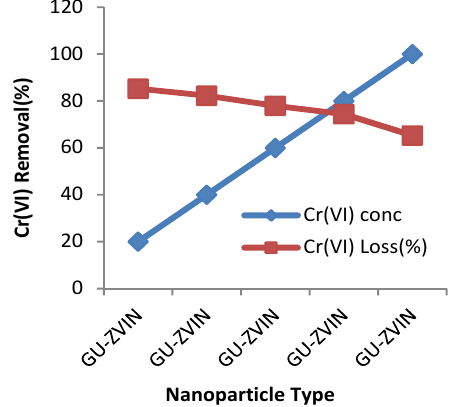
Fig.12.The removal efficiency of Cr(VI) using GG- ZVINs as a function of Cr(VI)